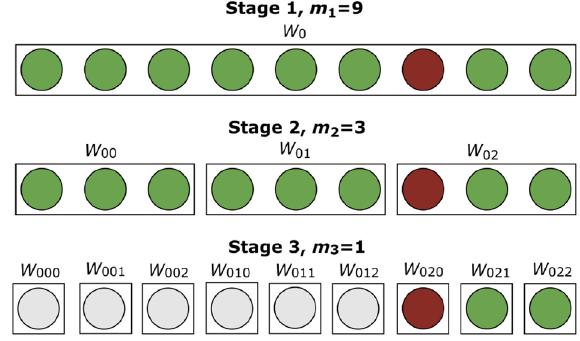
2 and m ( 9, 3 ) when applied Figure 1. Schematic depiction of the nested pool testing strategy with k = = to one pool labeled, W 0 . The circles represent individual samples and the rectangles represent pools. The red circles correspond to infected samples. The non-infected circles are either green (when they belong to a pool that is being tested at the corresponding stage) or grey (when they have been identified as non-infected at a previous stage). At the first stage all 9 samples of the pool, W 0 , are tested together. The result is positive due to the presence of one infected sample. W 0 is then divided into 3 sub-pools, W 00 , W 01 , W 02 , of 3 samples each that are tested at the second stage. After these tests, W 00 and W 01 , are identified as not infected so that the samples in them are not further tested. W 02 is identified as infected and all its samples are tested individually at the last stage. In the illustration the volume occupied by each pool seems to decrease from stage to stage: the pool volume is actually the same at all stages. The figure illustrates the labels, W i 1 ... i , that can be assigned a priori to j individual samples and pools of all stages, regardless of whether they are going to be tested as such or not. The labeling is characterized by a sequence of as many subscripts, i 1 , . . . , i j , as stage number with, i 1 , the subscript 0 that identifies the initial pool (in the figure, i 1 =